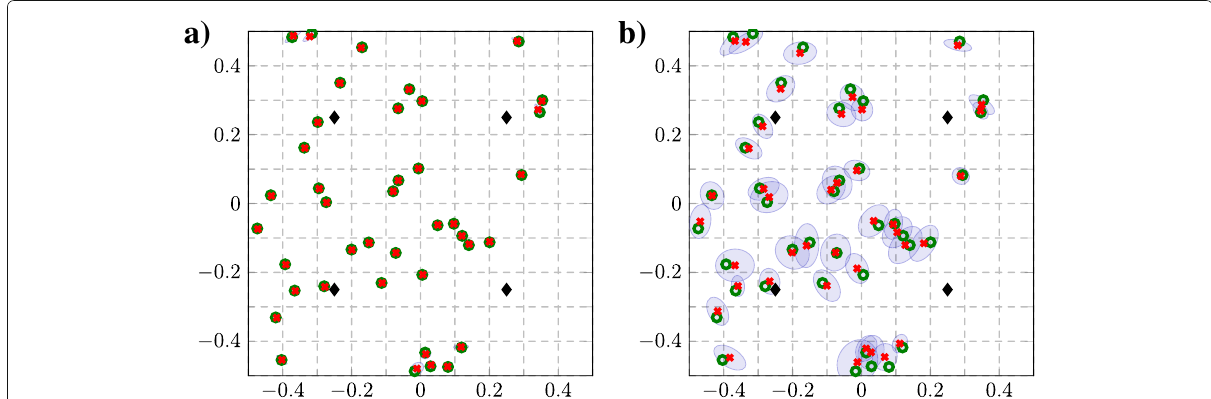
Fig. 13 Visualization of localization performance for 40 sensor motes, where a represents the case of unique identification (40 IDs) and b represents the case of only 10 IDs. These localization results were obtained by first resolving the transmit ambiguities and then applying the least-squares approximation presented in [11], where the measurement noise has been set to σ =